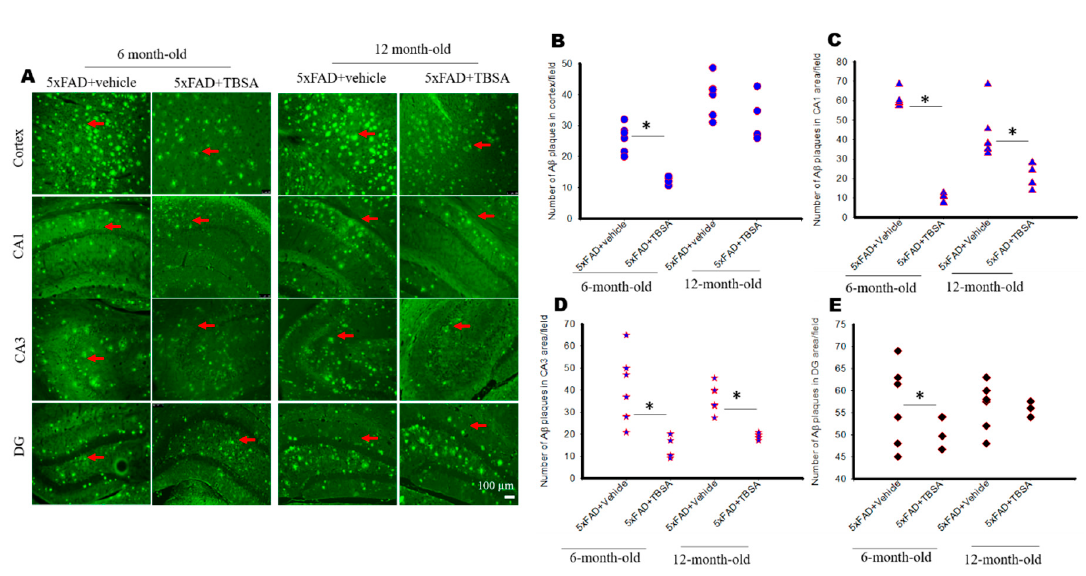
Figure 3. Treatments of trans-beta-styryl-boronic acid (TBSA) compound inhibited A β plaque load in brains of 5xFAD mice. Six- and twelve-month-old 5xFAD and age-matched control mice were treated with TBSA (0.5 mg / kg) or vehicle for 2 months and their brains were perfused with 4% paraformaldehyde. Forty-micron coronal sections were stained with A β using a curcumin-based solution (1 µ M, dissolved 70% methanol, for 10 min) and the images were taken using a fluorescent microscope with a 20x objective (total magnification = 200x). ( A ): Representative images show the amyloid plaques (arrows) in di ff erent brain areas in 5xFAD and 5xFAD mice treated with TBSA. ( B – E ): The number of A β plaques was significantly decreased by the treatment of TBSA in 6-month-old mice in cortex, CA1 and CA3 areas of hippocampus in comparison to 5xFAD-vehicle treated mice. The number of A β plaques was significantly decreased by the treatment of TBSA in 12-month-old mice in CA1 and CA3 areas of the hippocampus in comparison to 5xFAD-vehicle treated mice. Values are expressed as mean ± SEM; scale bar = 100 µ m and is applicable to all images. * p < 0.05 and in comparison, to 5xFAD + Vehicle-treated